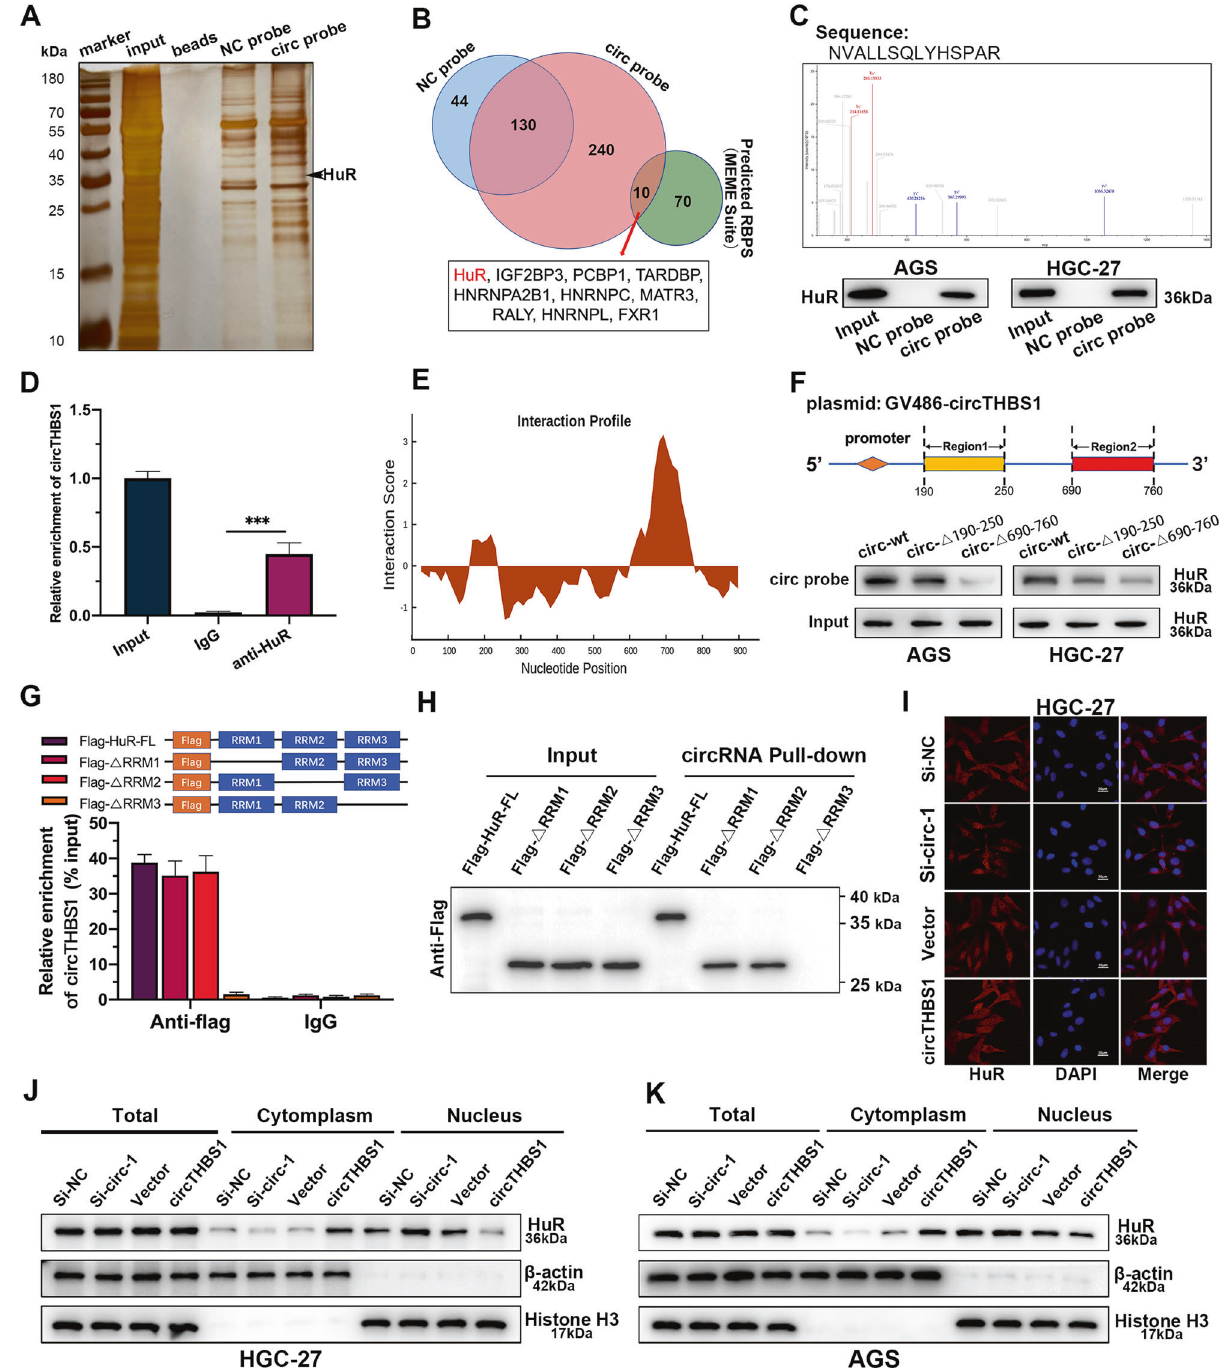
Fig. 5 CircTHBS1 interacts with HuR and promotes its cytoplasmic transport. A Silver staining of circTHBS1 pulldown. B Venn diagram showing the target RBPs of circTHBS1 from mass spectrometry and prediction of MEME suite. C The secondary mass spectrometry of HuR protein (top). Western blot veri fi ed that HuR was enriched in the circTHBS1 probe (bottom). D RIP assay shown that HuR protein precipitated with circTHBS1 in GC cell lysates. E The predicted binding regions of circTHBS1 with HuR. F The schematic diagram of the truncated fragment of circTHBS1 overexpression plasmids (top). After GC cells were transfected with wild-type or truncated circTHBS1 overexpression plasmids, RNA pull-down was performed with circTHBS1 speci fi c probes (bottom). G The full-length or truncated forms of fl ag-labeled recombinant HuR protein were incubated with HGC-27 cell lysates, then the recovered circTHBS1 levels were detected by qRT-PCR. H RNA pull-down experiments were performed by using circTHBS1-speci fi c probes against full-length or truncated forms of fl ag-tagged recombinant HuR proteins. I Immuno fl uorescent of HuR (red) in HGC-27 cells after knockdown or overexpressing circTHBS1. DAPI (blue) for nuclear staining. Original magni fi cation = 400×; scale bar = 20 μ m. J, K The expression levels of HuR in total lysates or subcellular fractions were detected by western blotting. AGS and HGC-27 cells were transfected with si-NC, si-circTHBS1, vector, and circTHBS1 overexpression plasmids. Quantitative data were presented as the mean ± SD. * P < 0.05, ** P < 0.01, *** P < 0.001 (Student ’ s t -test).